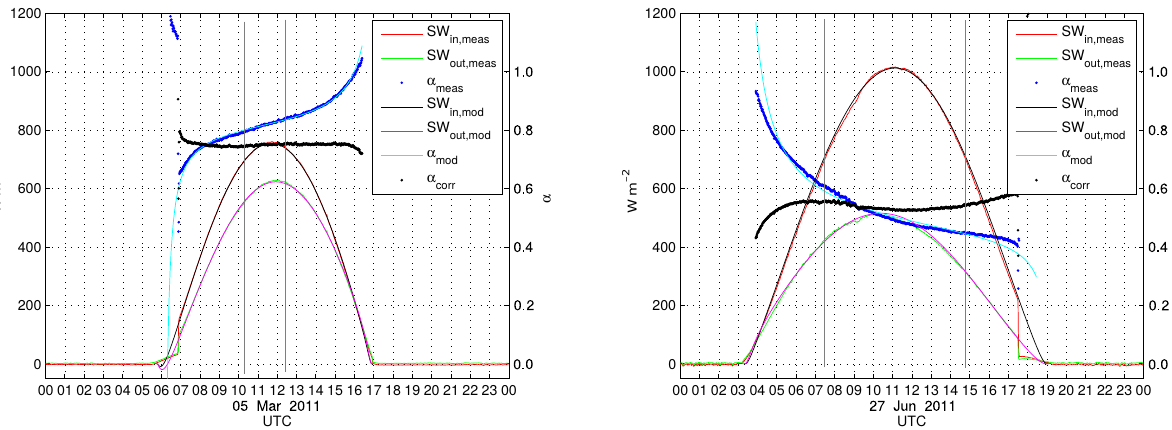
Figure 9. Directly measured (blue dots), modelled (cyan) and corrected (black dots) albedo calculated from data of an inclined pyranometer and a tilted slope at the location of the AWS on Kleinfleißkees on 5 March 2011 (left) and Goldbergkees on 27 June 2011